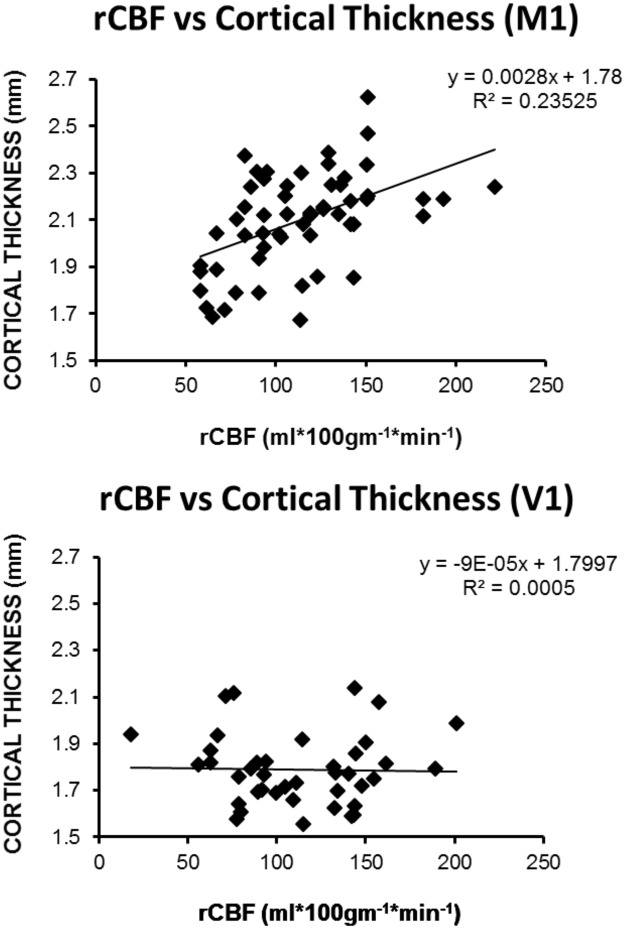
Scatterplots of cortical thickness versus CBF in primary motor cortex (M1, panel A) and in visual cortex (V1, panel B).